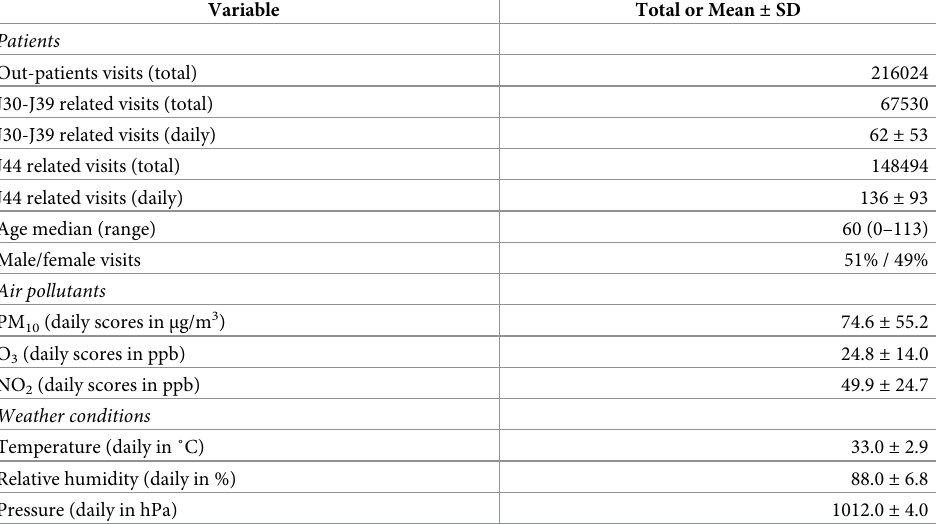
Table 1. Statistics for health and environmental variables as observed in the Chiang Mai province, Thailand, dur- ing October 2011 to September 2014.